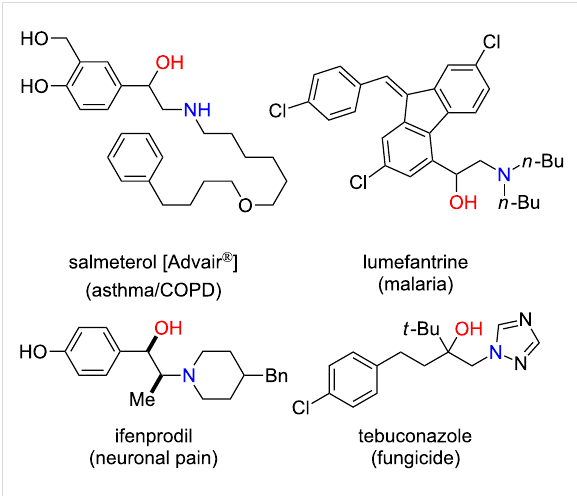
Figure 1: Examples of valuable 1,2-oxyamino-containing molecules.